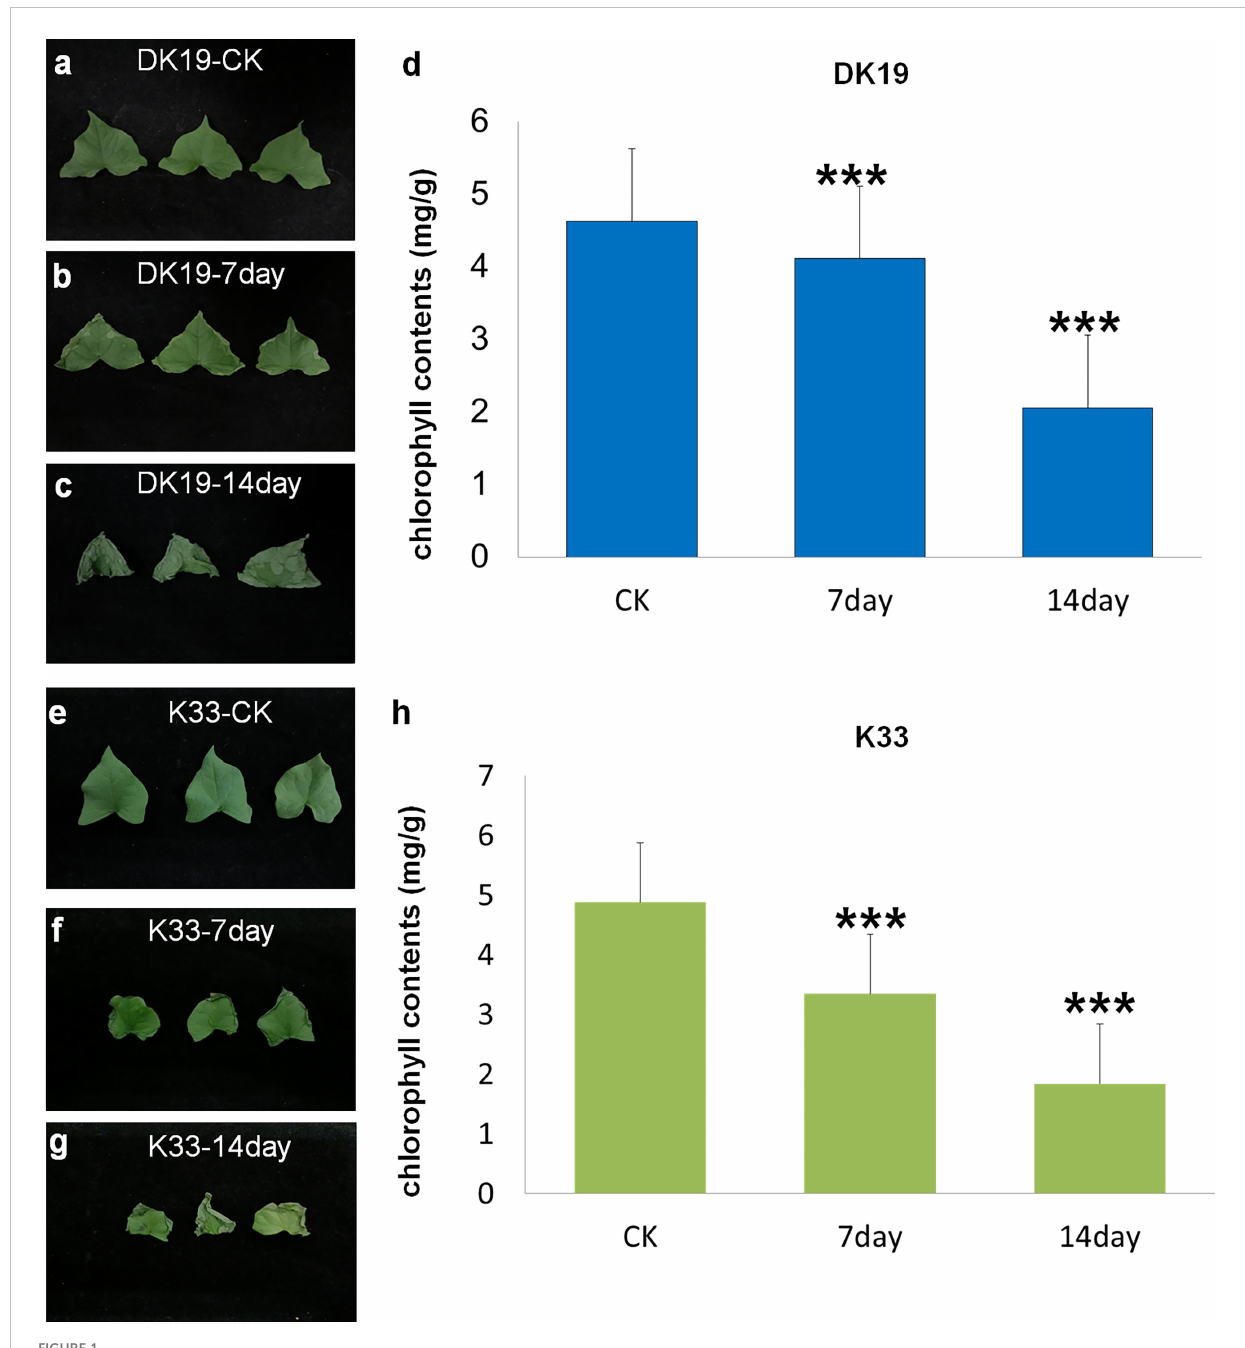
FIGURE 1 Phenotypic detected before and after Cd stress in DK19 and K33. (A) The phenotype of fresh buckwheat leaves was before treatment (CK) in buckwheat DK19. The leaves contain suf fi cient water, showing good spreading and extension, without wilting and drying. (B) The phenotype of fresh buckwheat leaves after seven days of Cd treatment in DK19. Leaves did not show signi fi cant variation relative to the control group. (C) The phenotype of fresh buckwheat leaves after 14 days of Cd treatment in DK19. The leaves wilted, showing a signi fi cant water loss state, but the leaves did not appear withered and yellow. (D) , The diversity in chlorophyll contents. The abscissa represents the samples with different treatments, and the ordinate is the chlorophyll content detected, in mg/g. (E) , The phenotype of fresh buckwheat leaves was before treatment (CK) in buckwheat K33. The leaves contain suf fi cient water, showing good spreading and extension, without wilting and drying. (F) , The phenotype of fresh buckwheat leaves after seven days of Cd treatment in K33. The leaves wilted, showing a signi fi cant water loss state, but the leaves did not appear withered and yellow. (G) , The phenotype of fresh buckwheat leaves after 14 days of Cd treatment in K33. The leaves showed signi fi cant wilting and serious water loss. A large number of withered and yellow states appeared at the edge of the leaves, and gradually extended to the center. (H) , The diversity in chlorophyll contents. The abscissa represents the samples with different treatments, and the ordinate is the chlorophyll content detected, in mg/g. *** P ≤